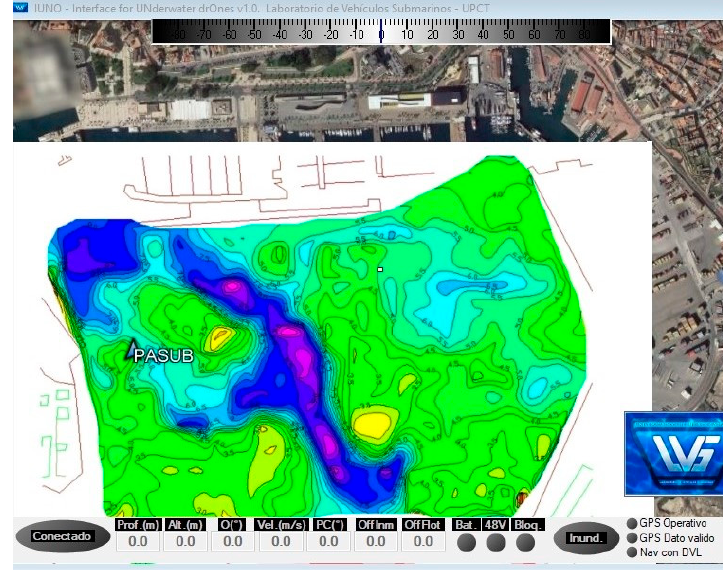
Figure 6. ASV control software.